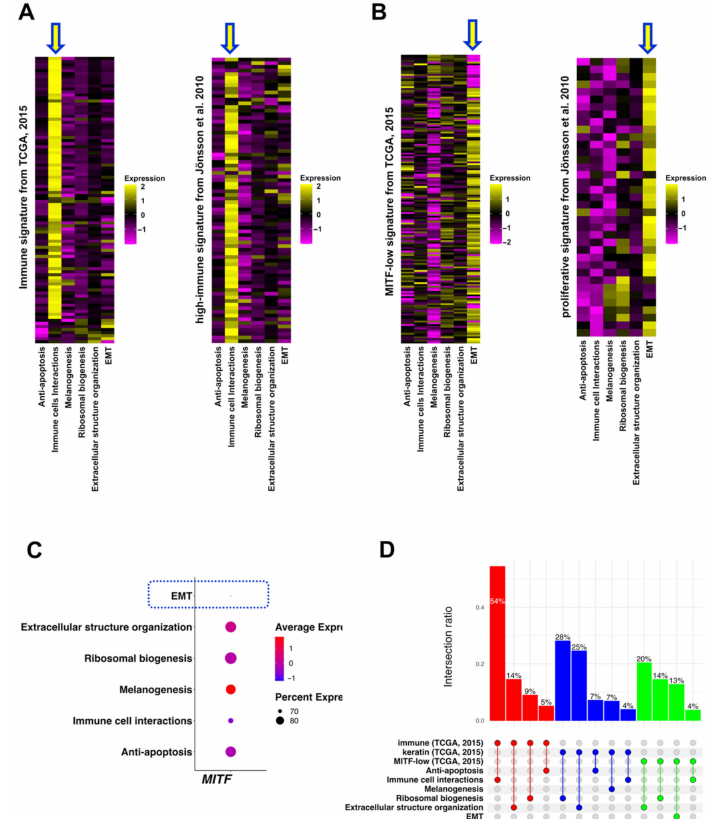
Figure 5. The identified GESs partially overlapped with previously reported GESs. ( A ) Heatmaps showing the expression of the representative genes of “immune” GES (left heatmap) and “high- immune” GES (right heatmap) in our identified TCGA GESs. Arrows indicating GESs with the highest similarity. ( B ) Heatmaps showing the expression of the representative genes of “MITF-low” GES (left heatmap) and “proliferative” GES (right heatmap) in our identified TCGA GESs. Arrows indicate GESs with the highest similarity. ( C ) Dot plot for the MITF expression levels in each GES. Dotted-line rectangle indicates the lowest expression level of MITF in “EMT” GES. ( D ) Upset plot visualizing the overlapping TCGA-SKCM patients between our GESs and previously reported GESs (“immune”, “keratin”, and